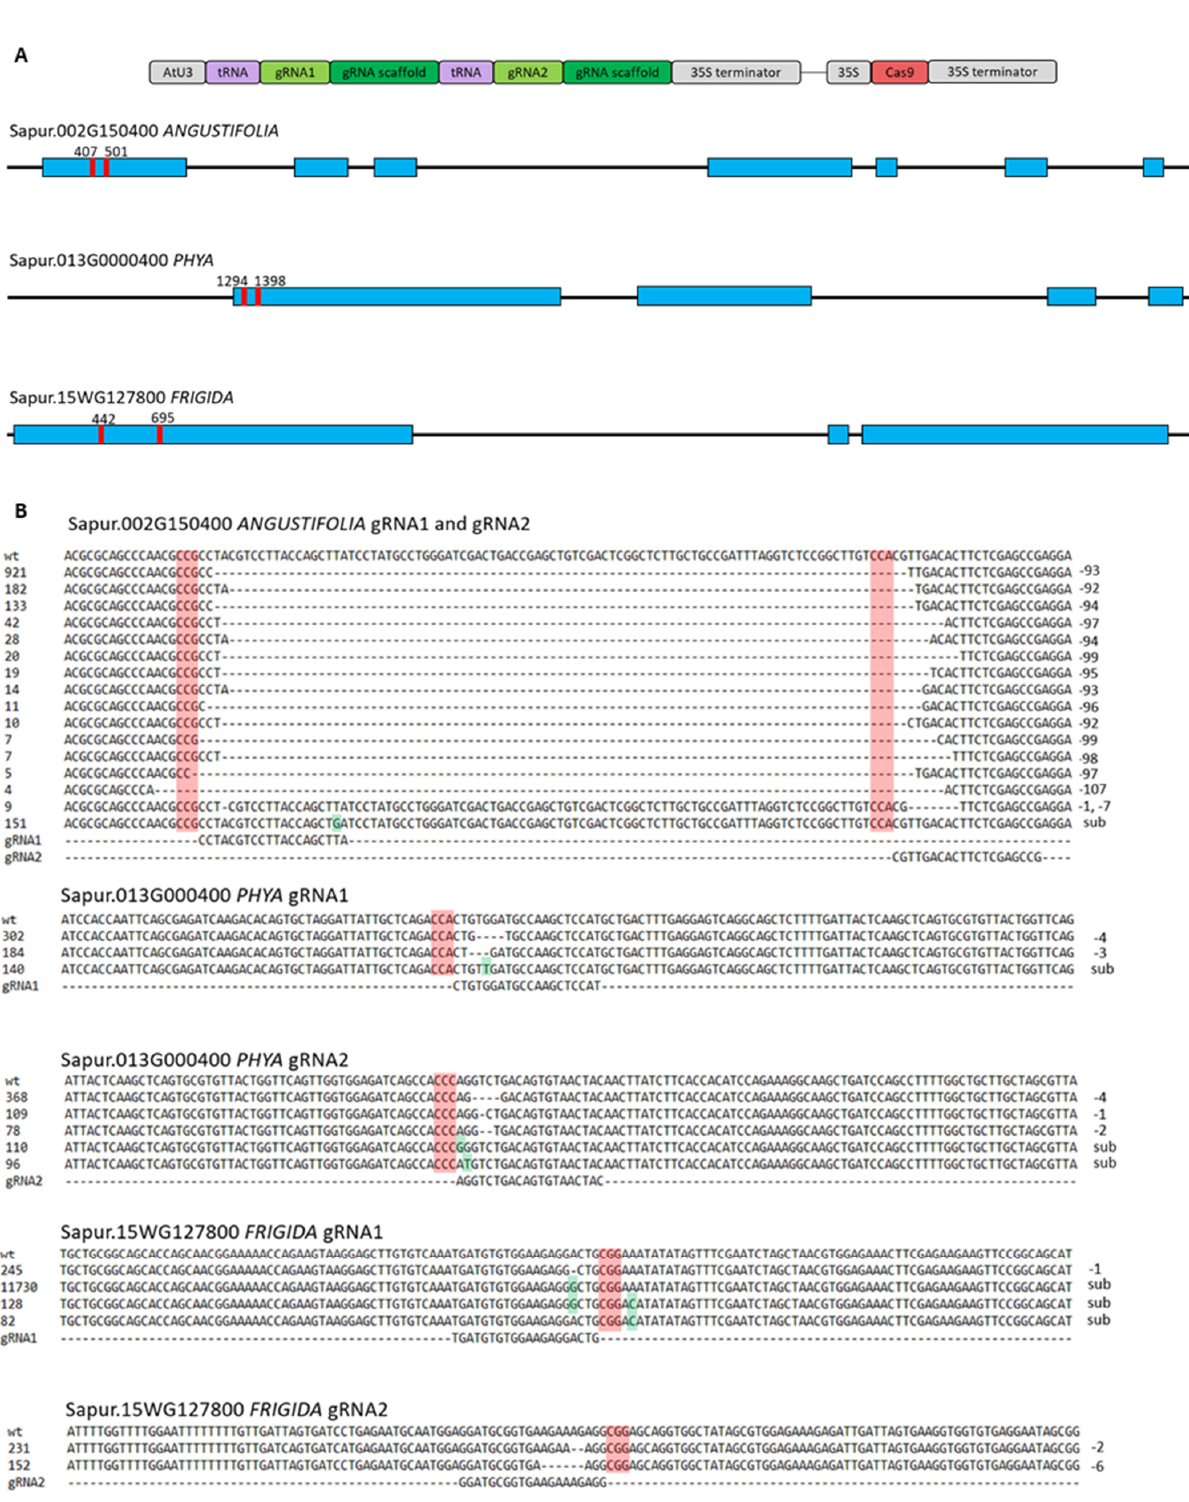
Figure 2. ( A ) Schematic showing the T-DNA design for CRIPSR/Cas9 mediated knockout, exons are shown in blue and gRNA binding sites in red, relative gene lengths are not shown to scale; ( B ) Alignments of CRISPR mutations with read counts ( left ) and mutation type ( right ) for each of the six gRNAs. For brevity, alternative haplotypes with the same mutation were combined, PAM sequences are highlighted in red, and substitutions are highlighted in green.